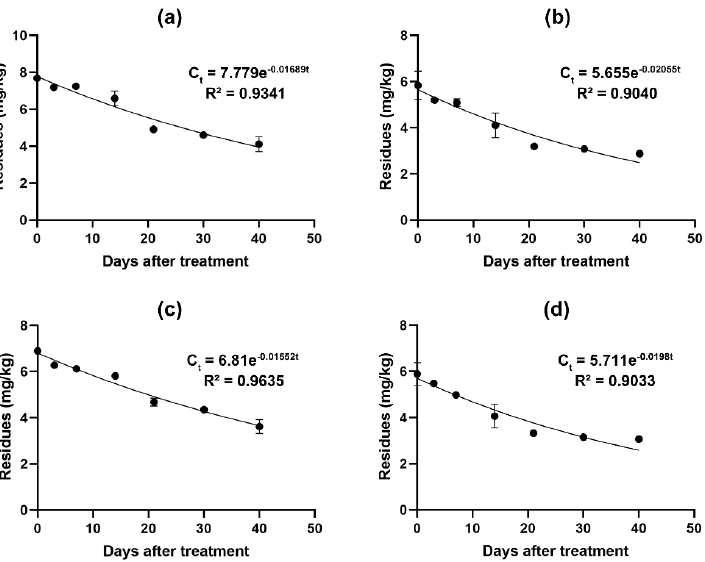
Figure 3. Dissipations of fludioxonil in cherry samples from ( a ) Anhui, ( b ) Beijing, ( c ) Henan, and ( d ) ( d ) Shandong.